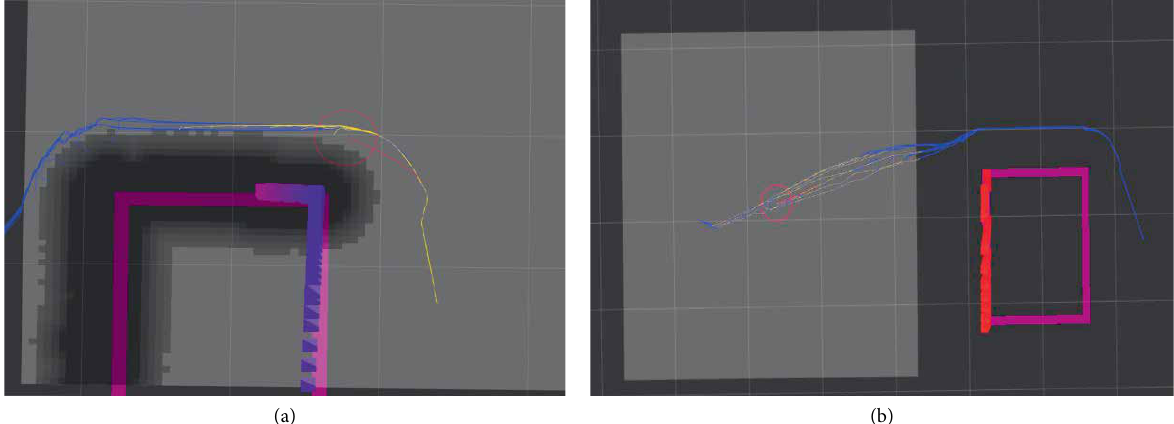
Figure 2: Possible detection results. The red circle represents the robot, the red line represents the actual path result, the blue line represents the global path plan, the yellow line represents the local path plan, and the purple rectangle represents the obstacle. (a) Detected incomplete path. (b) Over-detected paths.